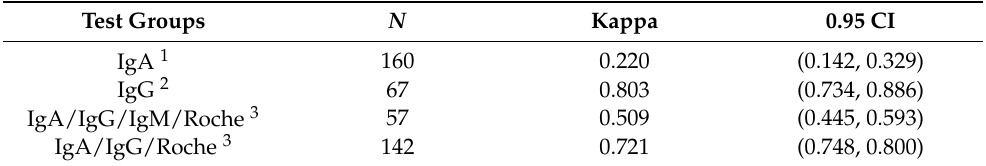
Table 6. Agreement between the tests by immunoglobulin classes and in overarching